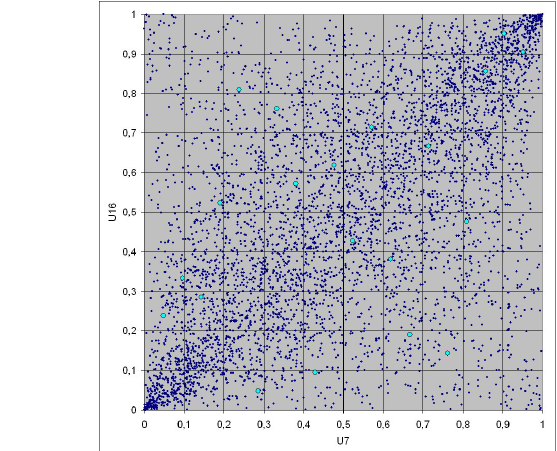
Figure 35: t -copula with two degrees of freedom,